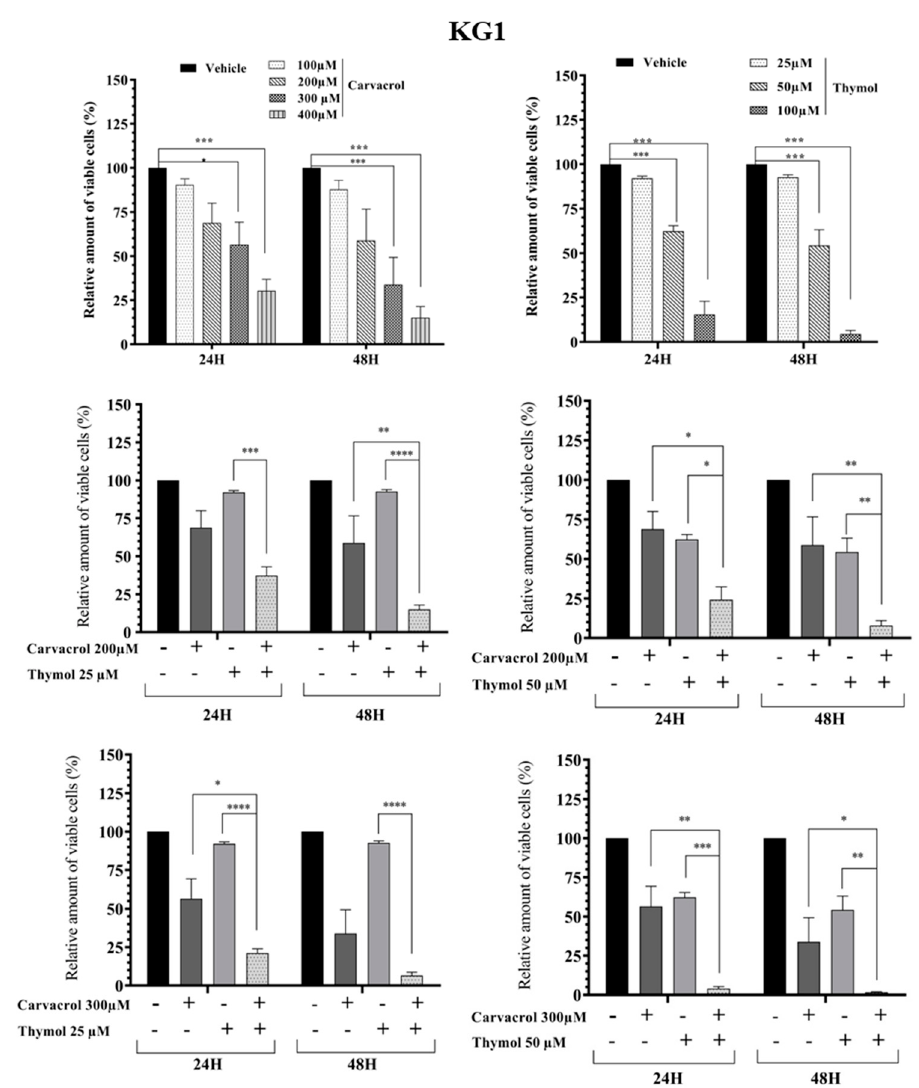
Figure 3. Impact of carvacrol, thymol, and their combination on the viability of the KG1 myeloid leukemic cells. Flow cytometric analysis of cell death with Annexin V-FITC/PI double staining after 24 h and 48 h treatment with different concentrations of carvacrol and thymol (individually or in combination). Data represent the mean ± SEM of three independent experiments relative to vehicle. The levels of statistical significance were p < 0.05 (*), p < 0.01 (**), p < 0.001 (***), and p < 0.0001 (****).